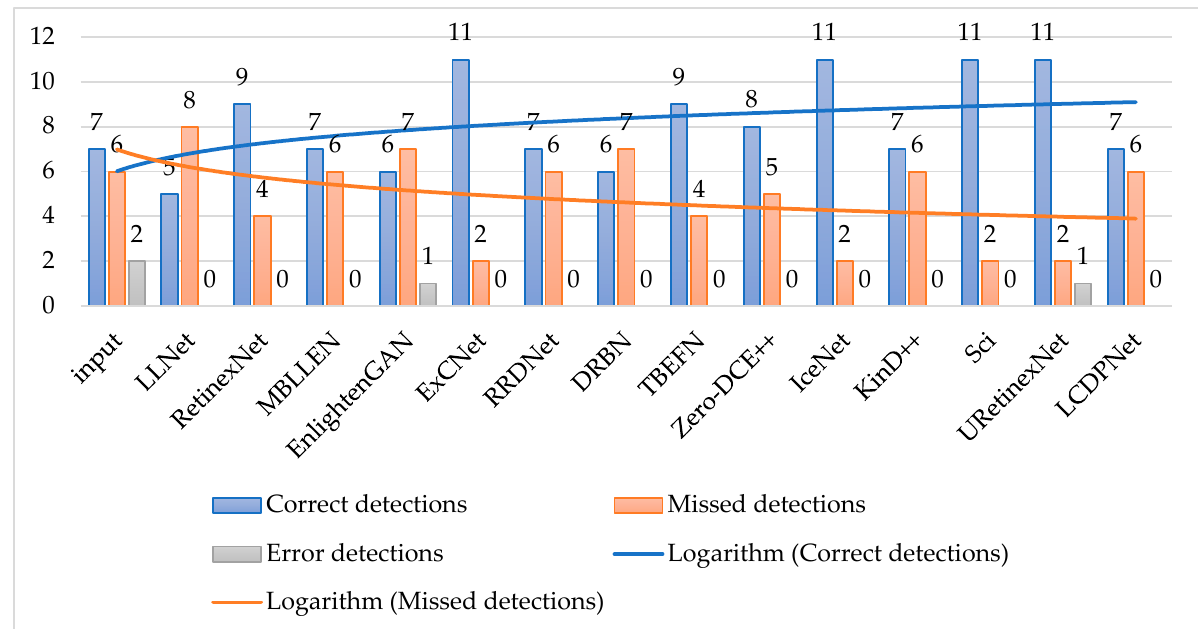
Figure 12. Low-illumination face detection performance comparison graph.